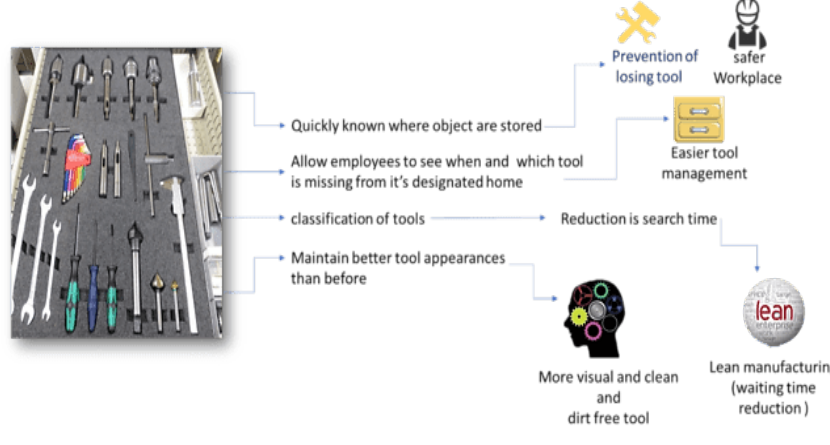
Fig. 5. Outcome model of shadow boarding of tooling set of manufacturing